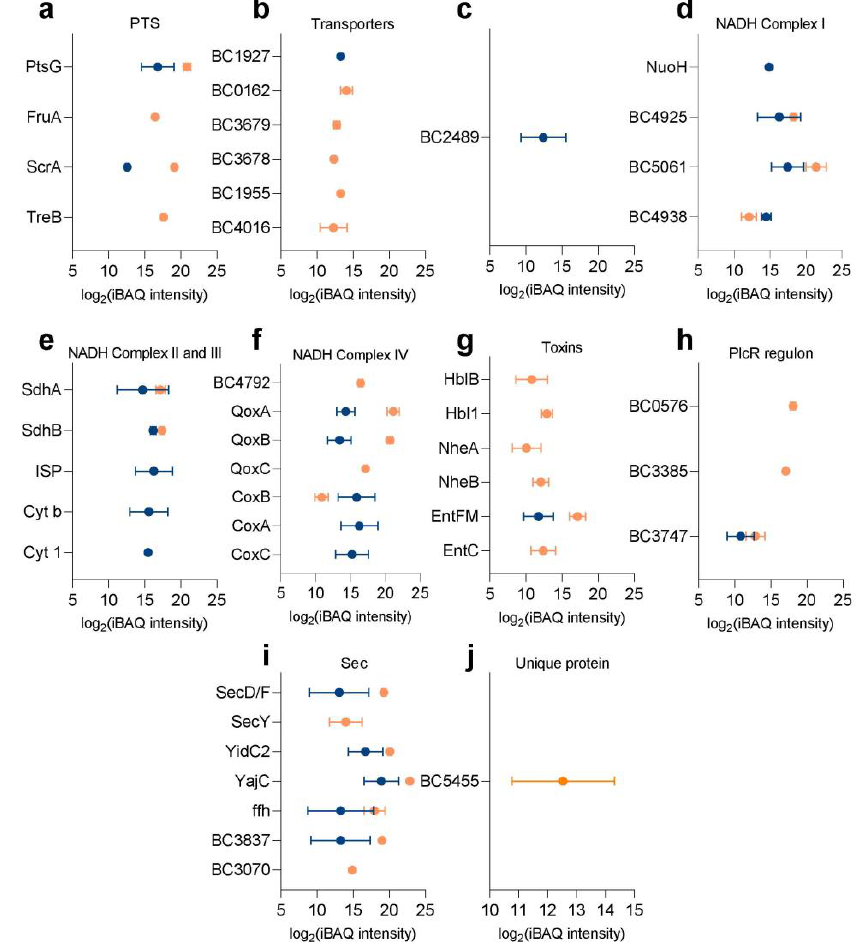
Figure 5. Abundances of proteins with vital functions in the cell or spore membrane. The iBAQ values of proteins from spore inner membrane (blue) and from the vegetative cell membrane (orange) associated with PTS ( a ), transporters ( b ), acetyl-coenzyme A synthetase ( c ), NADH complex I ( d ), NADH complex II and III ( e ), NADH complex IV ( f ), toxins ( g ), PlcR regulon ( h ), Sec system ( i ) and a unique protein ( j ) are shown, see text for details.